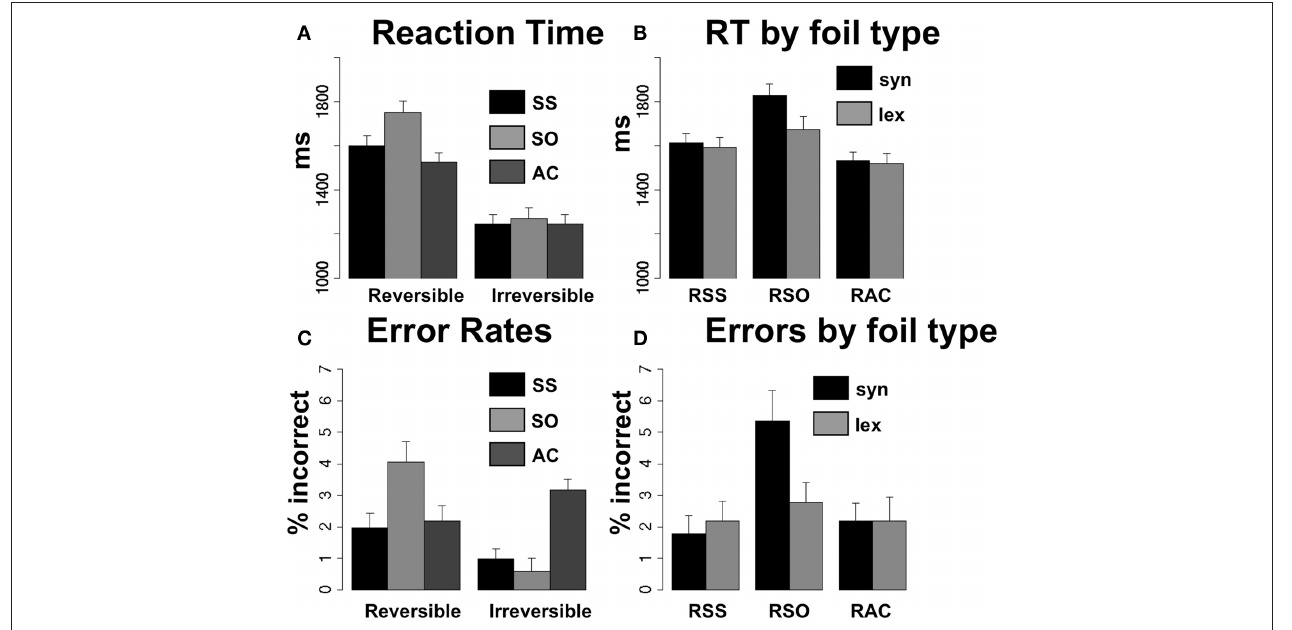
FiguRE 2 | Behavioral results. (A) Reaction time across the six sentence types, collapsed across foil type. (B) Reaction time for reversible sentences further divided by foil type, syntactic or lexical. (C) Error rate (% incorrect or no response) across sentence conditions. (D) Error rates for reversible sentences, further divided by foil